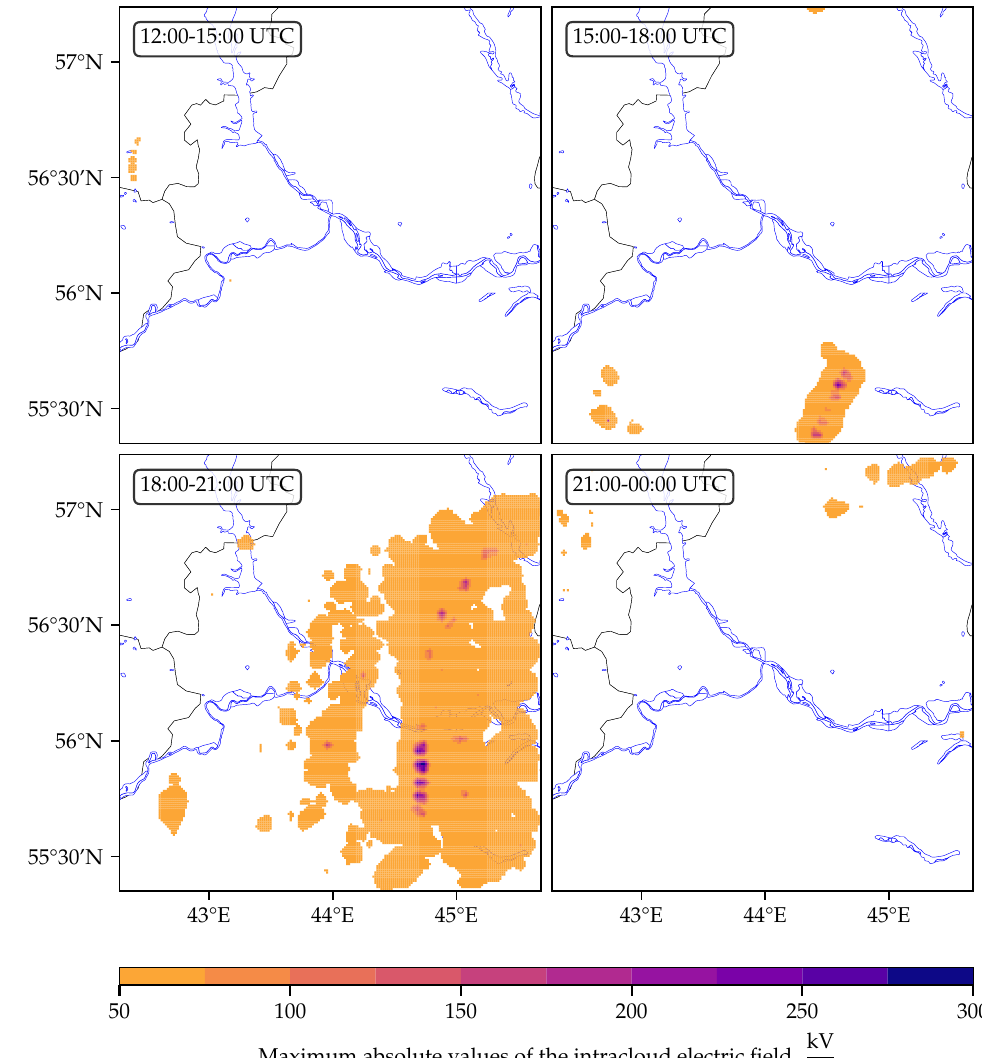
Figure 9. Maximum absolute values of the intracloud electric field every 3 h from 12:00 13 July 2020 to 03:00 14 July 2020, obtained by modeling with non-aerosol parametrization of the